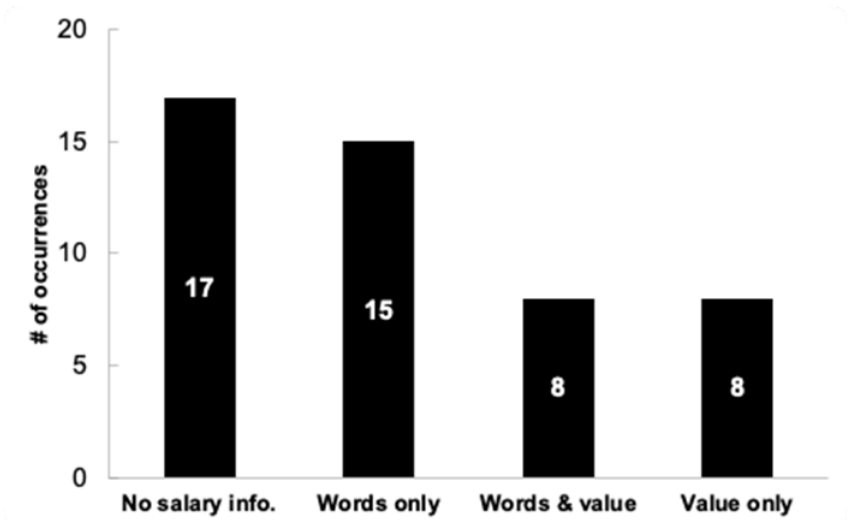
Figure 1 : How salary was described in the job positions ( n = 48)